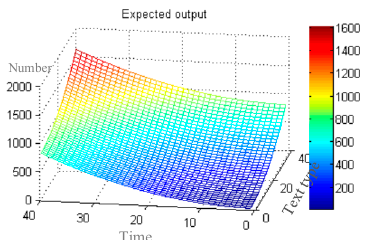
Figure 9. Predicted data secondary optimization.